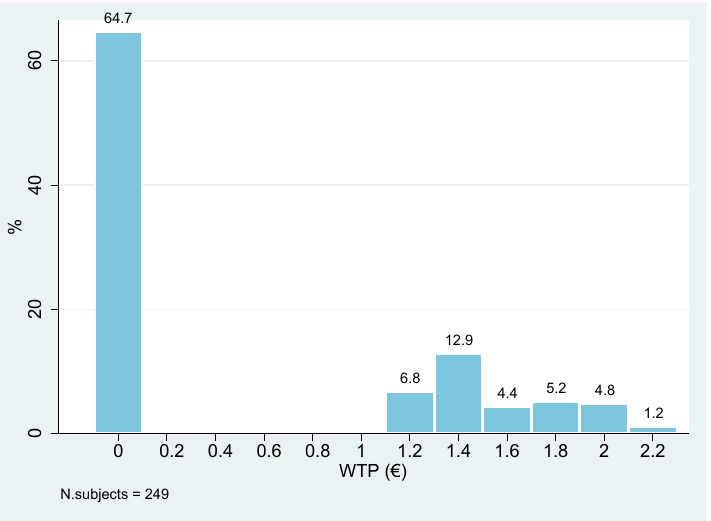
Figure 2. Contingent valuation results: histogram of declared WTP for a 90 g tin of Chianina meat by respondents (full sample). Percentages calculated on 249